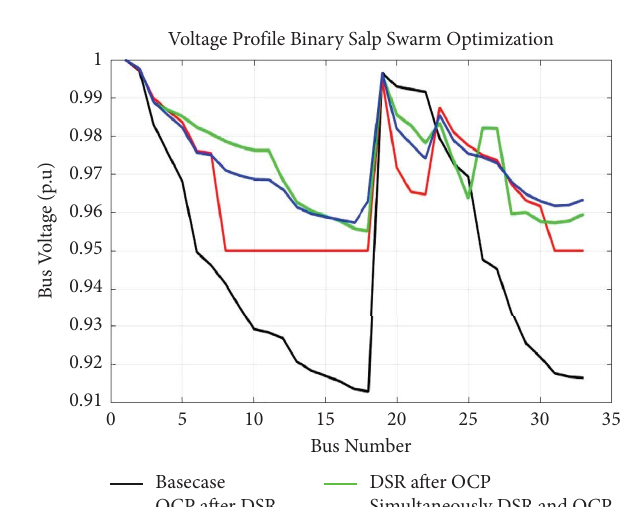
Figure 8: 33-bus IEEE system for scenario 3.